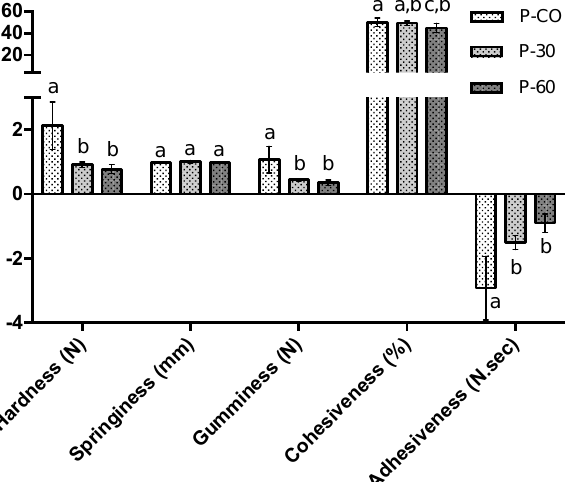
Figure 2. Texture (hardness; springiness; cohesiveness; gumminess and adhesiveness) for P-CO, P-30 and P-60 pâté samples, as a result of texture profile analysis (TPA) analysis. a-c Different letters (in the same parameter) mean that samples are statistically different (α = 0.05).